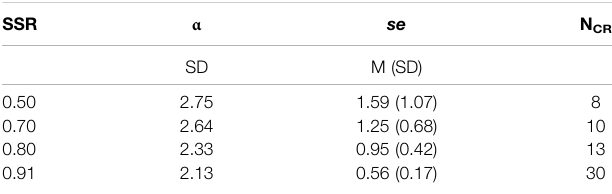
TABLE 1 | For each reference set (SSR) the standard deviation of ability estimates ( α , n = 140), mean and standard deviation of standard error of estimate ( se , n = 140) and the number of comparisons per representation to reach this reference set (N CR